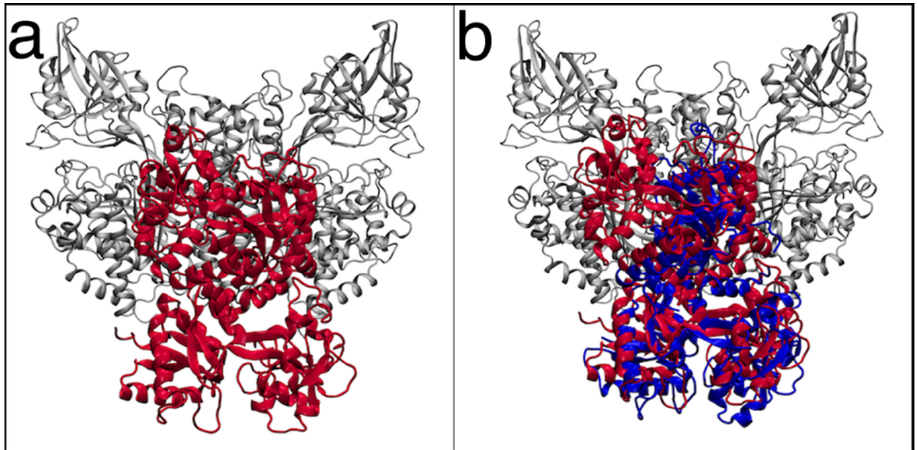
Figure 7. ( a ) Complex between human lactoferrin (hLf) (in red) and transferrin receptor 1 (TfR1) (in grey) obtained through molecular docking simulations. ( b ) Superposition of the hLf-TfR1 docking pose with the Tf-TfR1 crystallographic structure (PDB ID: 3S9L).